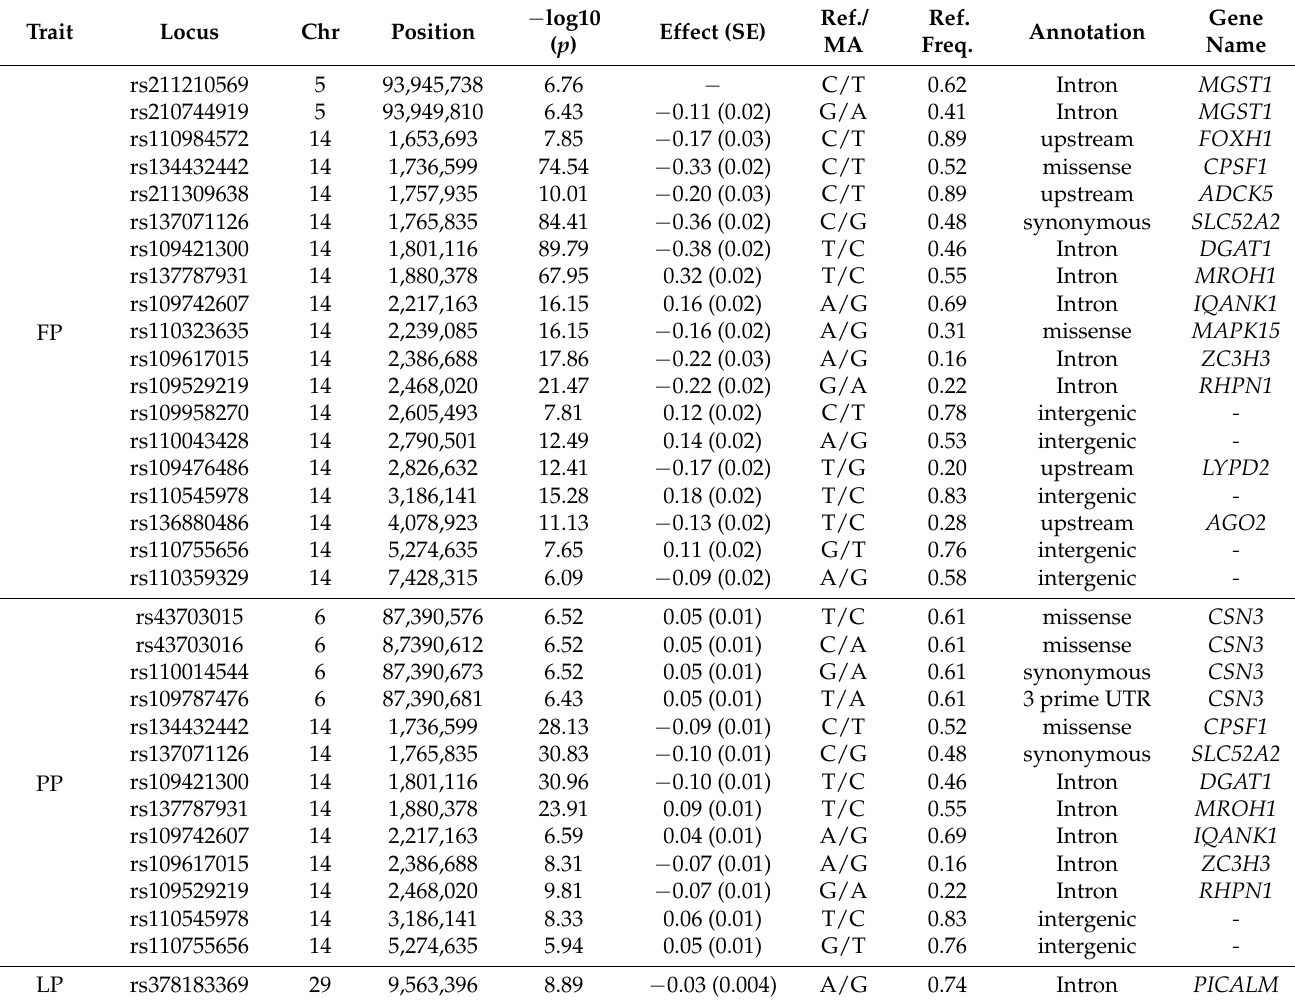
Table 3. The genome-wide significant single nucleotide polymorphisms (SNPs) for the milk composi- tion traits of fat percentage (FP), protein percentage (PP), and lactose percentage (LP). Trait Locus